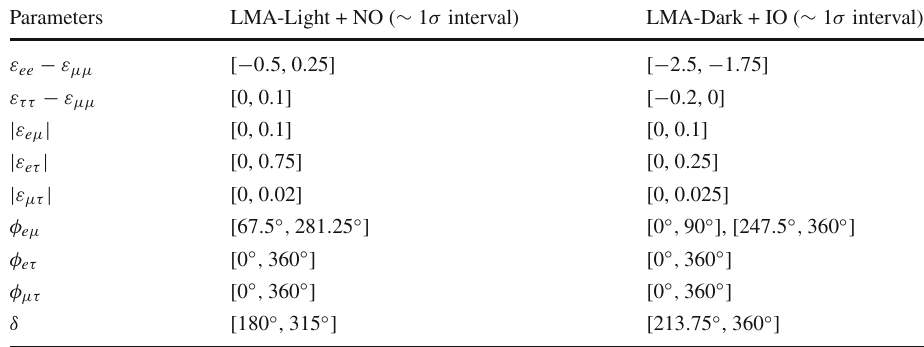
Table 1 1 σ interval of NSI parameters taken from Ref.